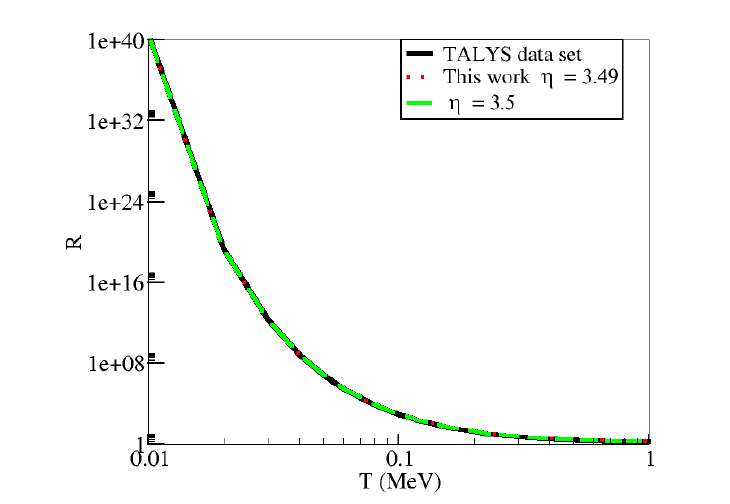
Figure 5. The same as Figure 4 but for 46 Mg.